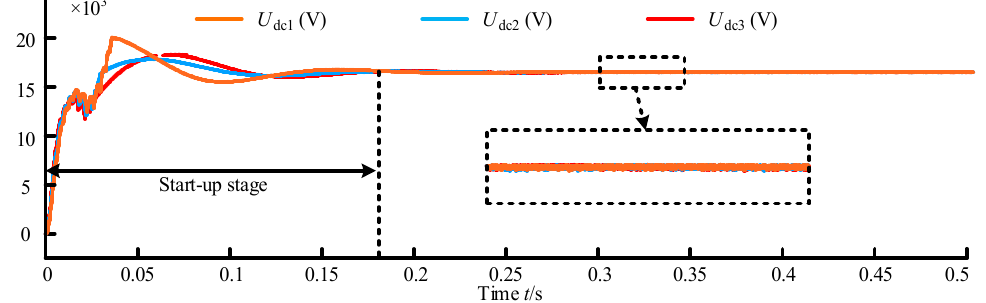
Figure 12. The output voltage waves of three three-phase rectifiers.